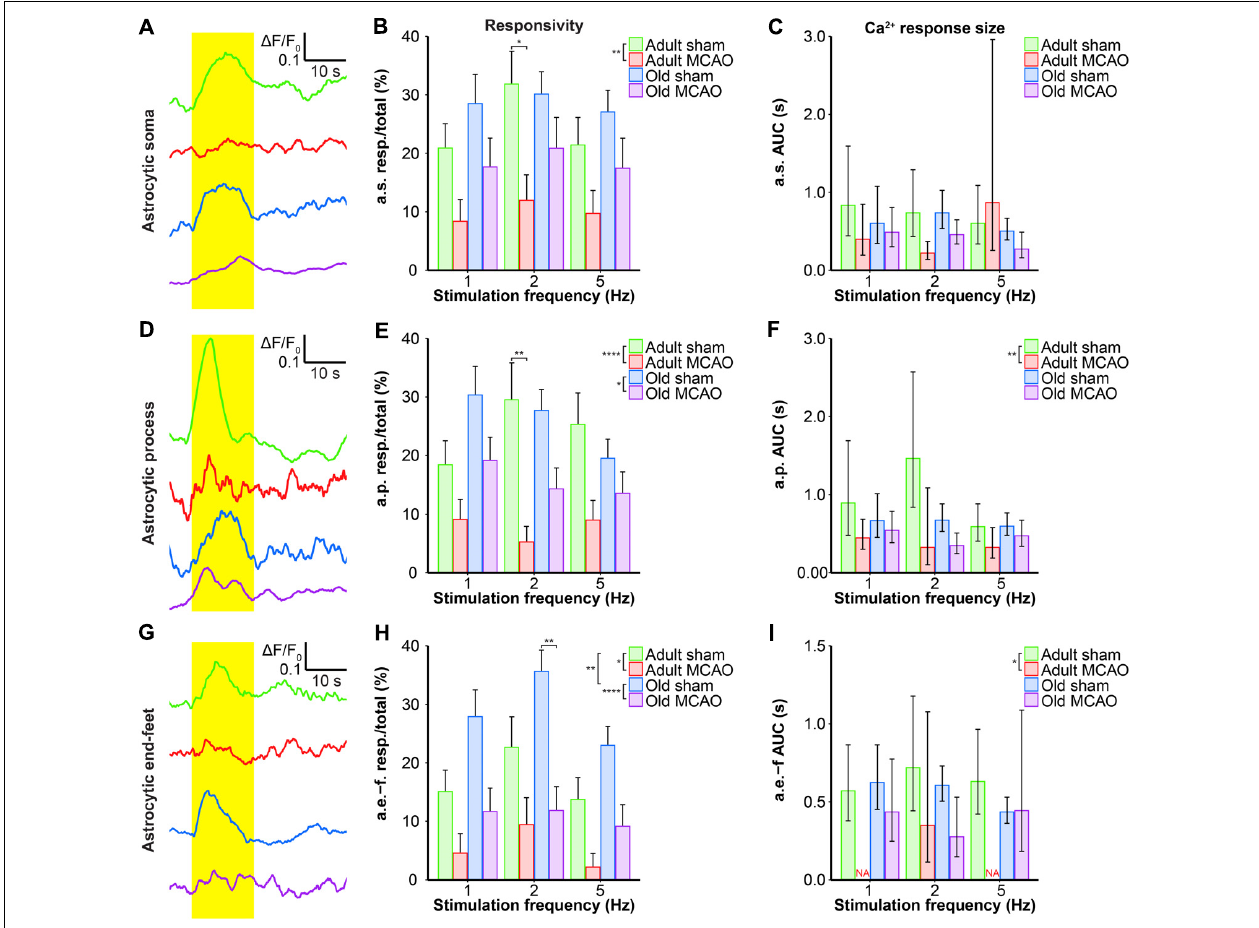
FIGURE 5 | Quantification of the stroke-induced reduction of evoked astrocytic Ca 2 + signals. (A,D,G) Representative smoothed traces of (cid:49) F/F 0 from astrocytic somas (a.s.) (A) , astrocytic processes (a.p.) (D) , and astrocytic end-feet (a.e.-f) (G) , following stimulation at 2 Hz for 15 s, in adult sham (green), adult middle cerebral artery occlusion (permanent MCAO; red), old sham (blue), and old MCAO (purple) mice. (B,E,H) Evoked Ca 2 + responsivity of astrocytic somas, processes, and end-feet. Responsivity is shown as the fraction of responsive (resp.) regions of interest (ROIs) relative to the total number of ROIs. In adult mice, stroke decreased the responsivity of astrocytic somas, processes, and end-feet. In old mice, stroke only decreased the responsivity of astrocytic processes and end-feet (to a lesser degree than in adult mice). Stroke particularly decreased responsivity at the 2-Hz stimulation frequency in astrocytic somas ( p = 0.0478; adult sham vs. adult MCAO), astrocytic processes ( p = 0.0064; adult sham vs. adult MCAO), and astrocytic end-feet ( p = 0.0048; old sham vs. old MCAO). (C,F,I) Size of the evoked Ca 2 + response shown as AUC ( (cid:49) F/F 0 × s) in astrocytic somas, astrocytic processes, and end-feet. In adult mice, stroke reduced evoked Ca 2 + response size in astrocytic processes and end-feet. Values are given as fraction ≤ standard error of probability for responsivity, and as back-transformed estimates ± 95% confidence intervals for AUC. Stroke nearly abolished evoked Ca 2 + responses in astrocytic end-feet at stimulation frequencies of 1 and 5 Hz; therefore, AUC was not examined (NA). Responsivity was analyzed using multinomial logistic regression, and AUC with linear models—and both with Holm-Sidak post hoc tests. ∗ Significant difference between treatments (i.e., experimental conditions). ∗ placed in the legend indicates overall effects, while the symbol over bars indicates group differences for an individual stimulation frequency. ∗ p ≤ 0.05, ∗∗ p ≤ 0.01, ∗∗∗ p ≤ 0.001, ∗∗∗∗ p ≤